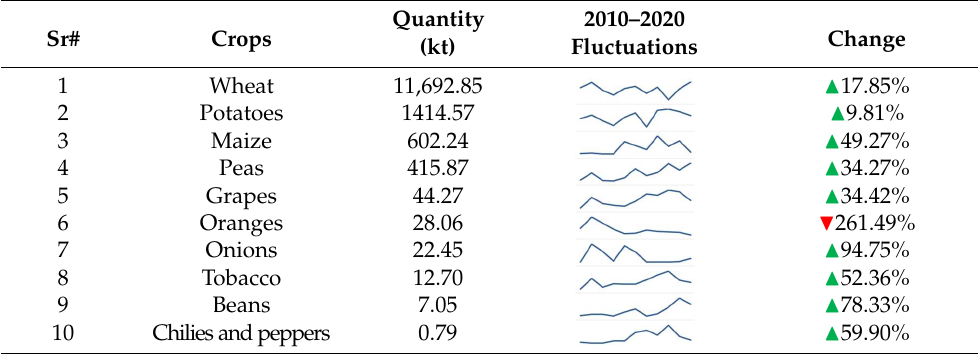
Table 1. Top ten imports of Sri Lankan crops based on last eleven years (2010–2020), ( ▲ Positive change in import of crops from 2010-2020, ▼ Negative change in import of crops from 2010-2020).